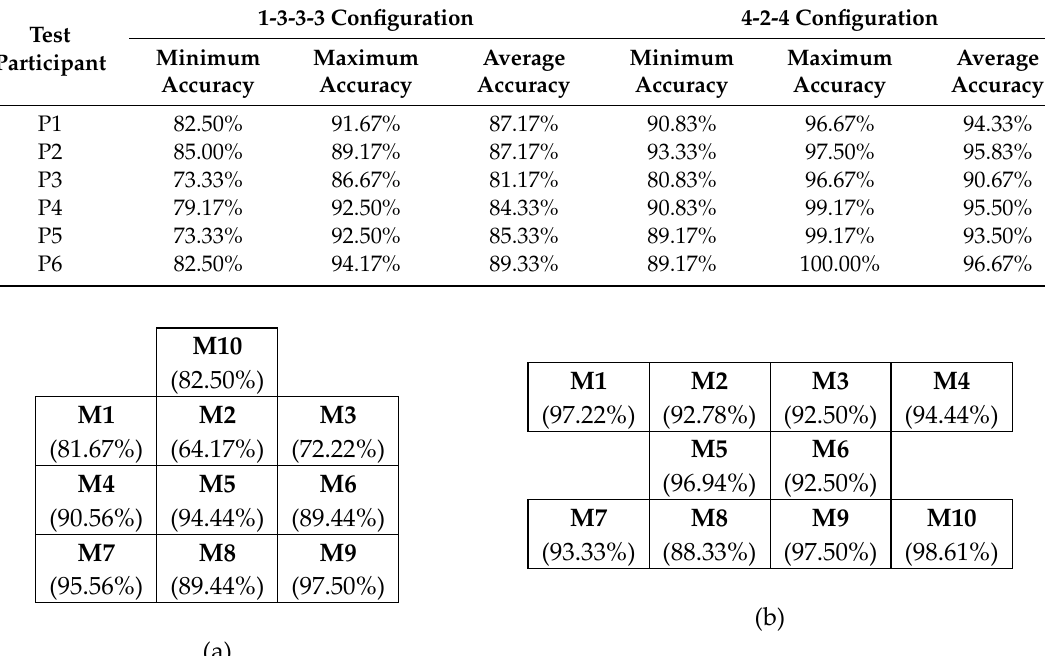
Table 5. Preliminary configuration test summary.